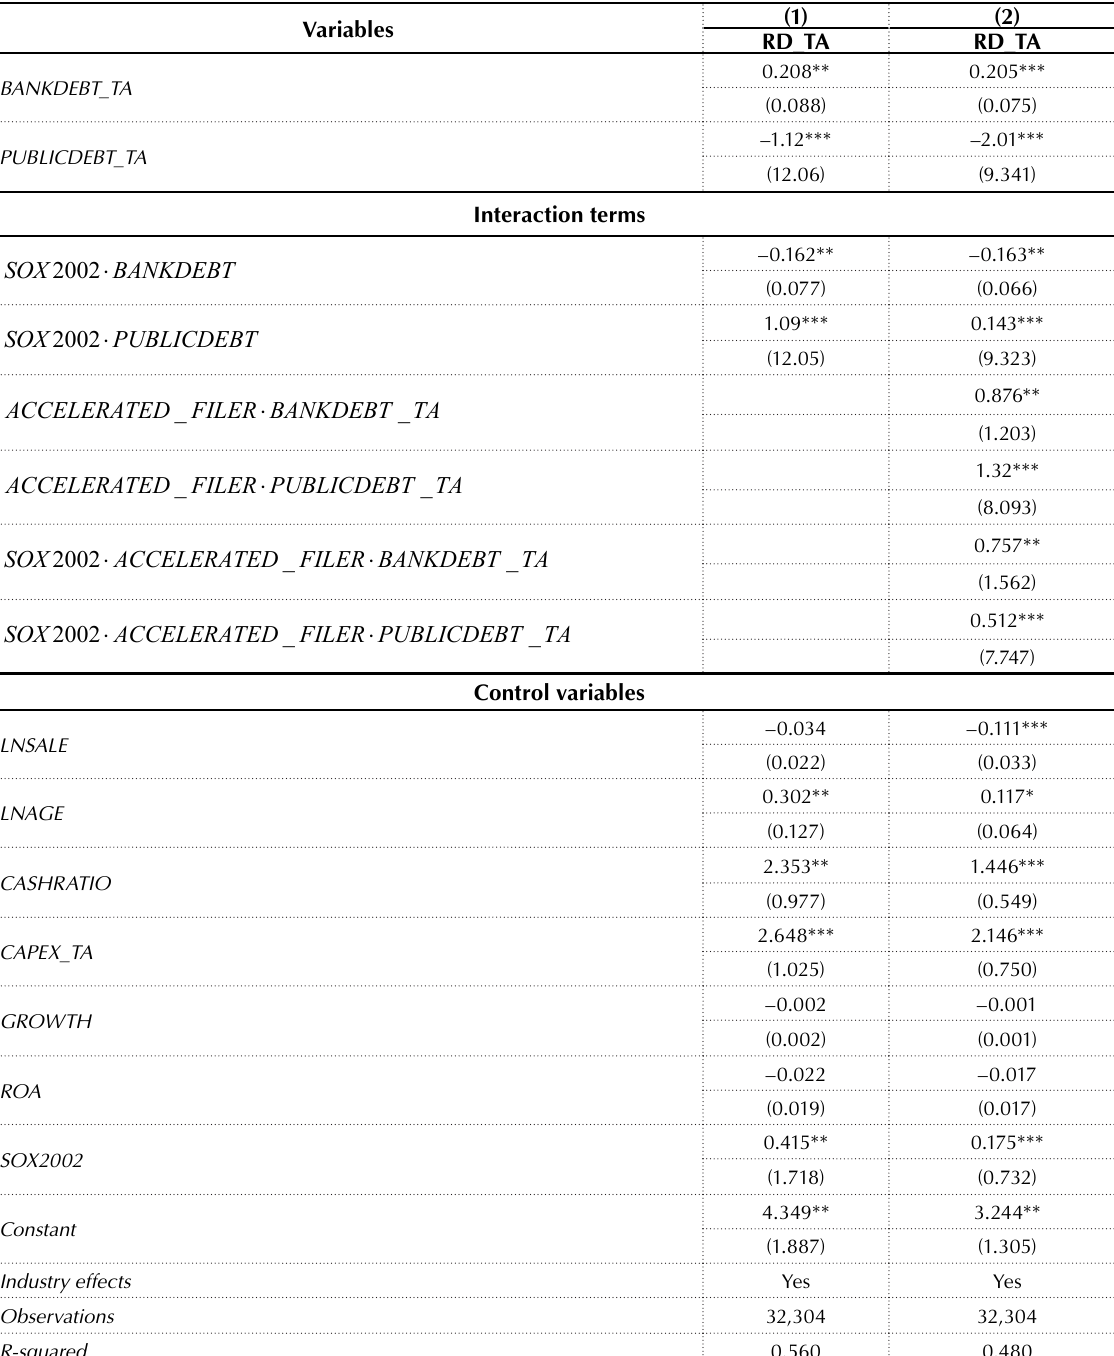
Table 4. Multivariate difference-in-differences analysis and robustness checks